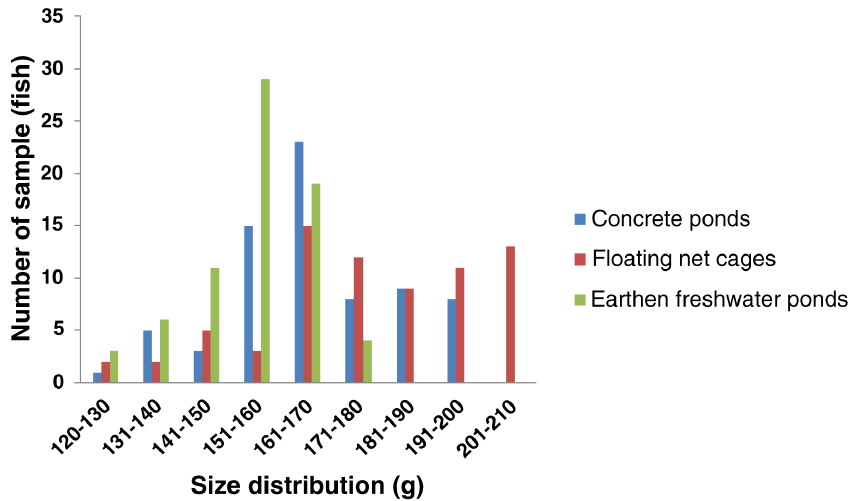
Figure 2. Distribution of gurami sago in the different aquaculture systems ( N